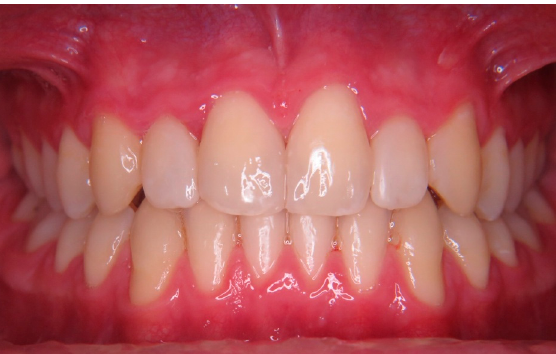
Figure 10. Case 3 Figure 10. Case 3 postoperative.